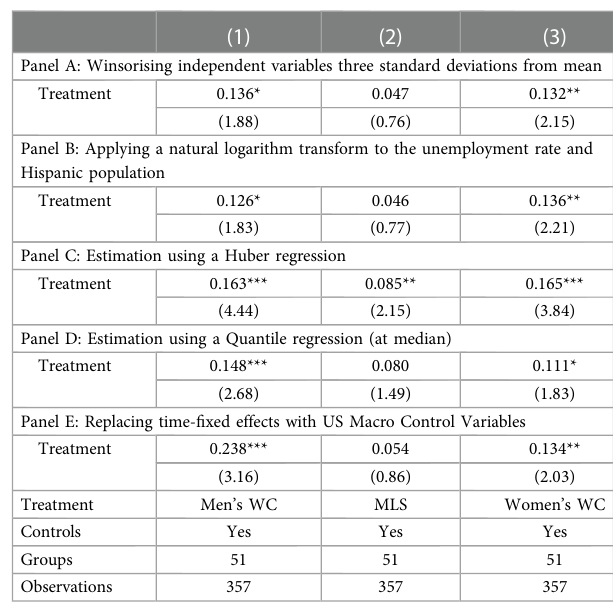
Panel E: Replacing time- fi xed effects with US Macro Control